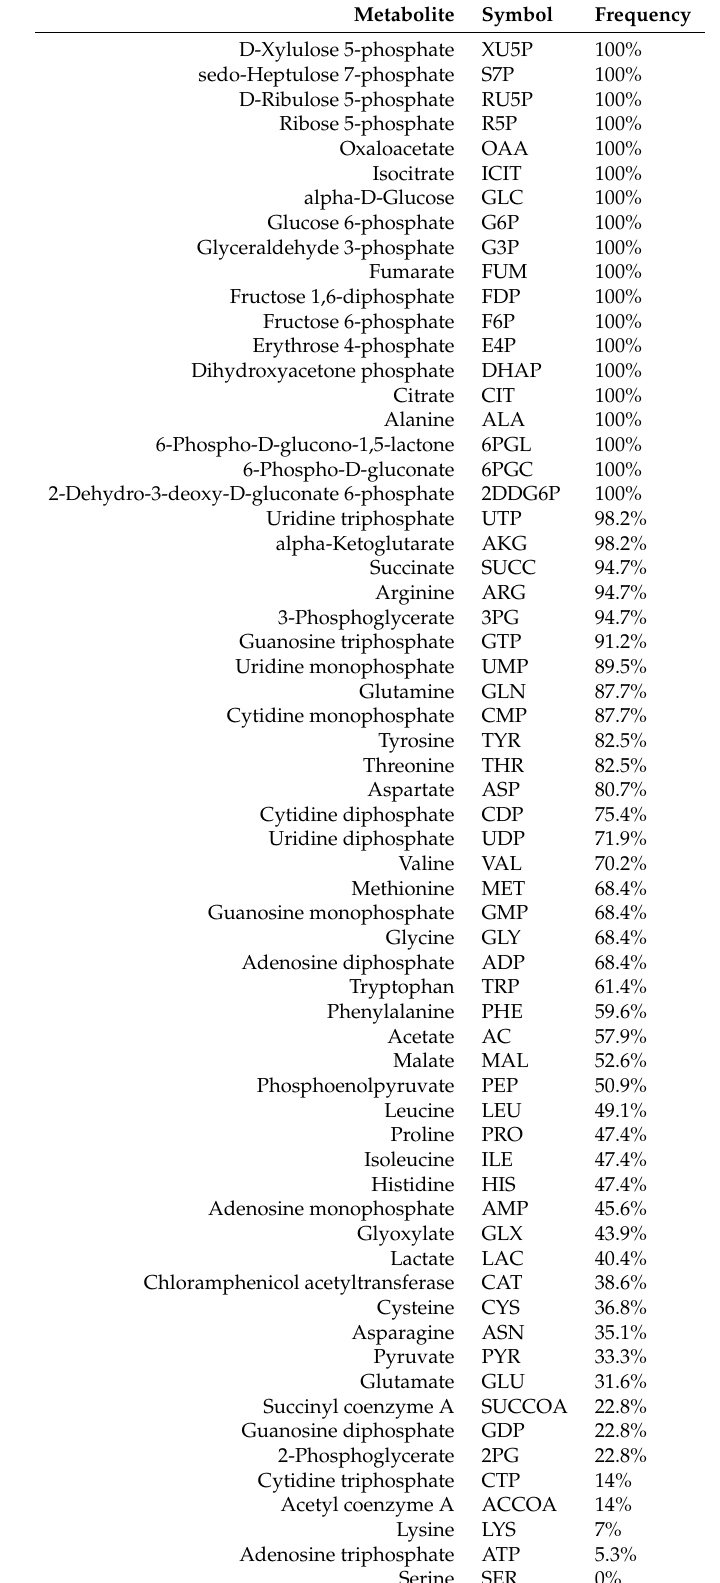
Table 5. Metabolites by frequency of appearance in the 57 best simulated annealing constraint sets, those with error at least three orders of magnitude lower than the base synthetic